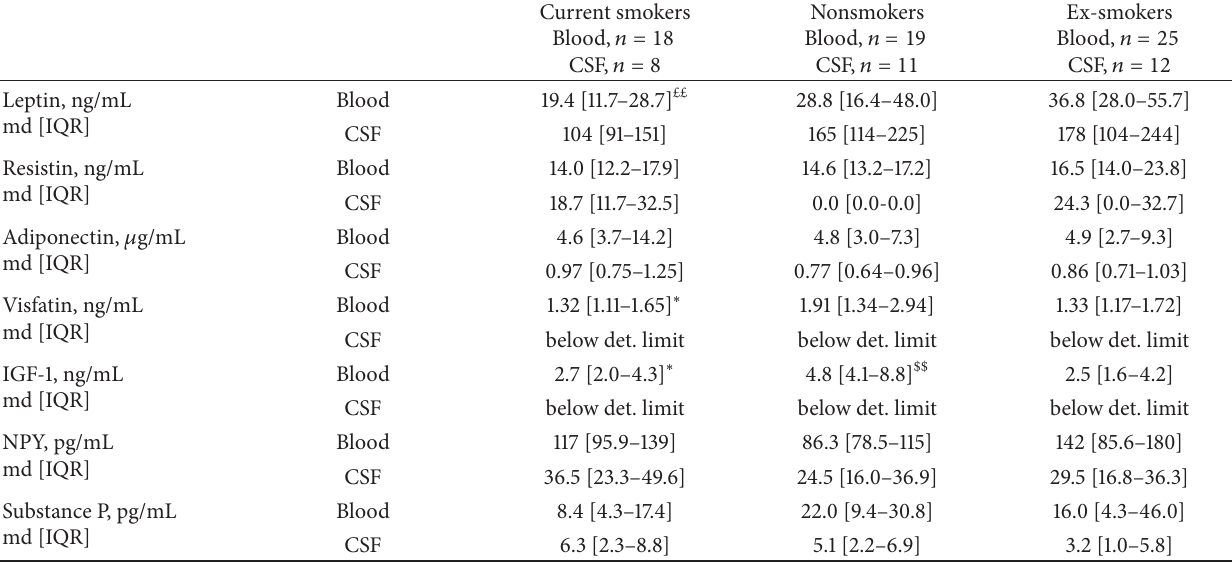
Table 2: Levels of adipokines and IGF-1 in the blood and cerebrospinal fluid of smokers and